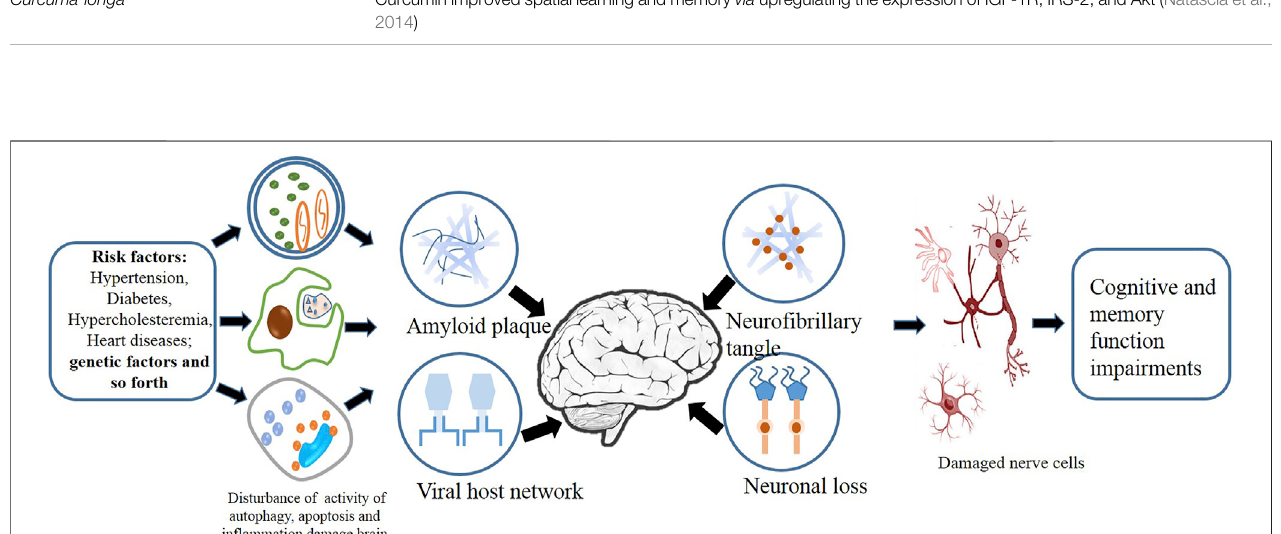
FIGURE 3 | Factors including in fl ammation, autophagy, and apoptosis act on the complex cellular network of the brain.